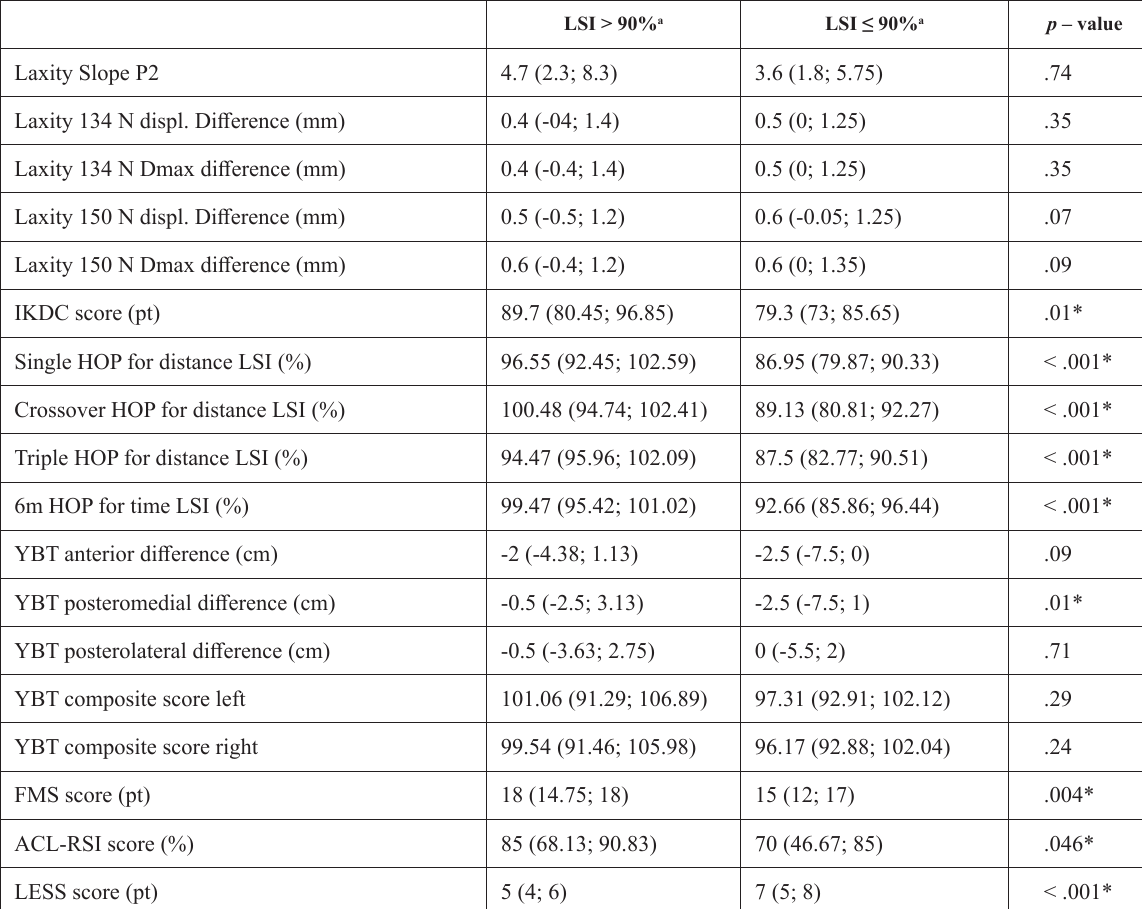
Table 2. Knee function tests and questionnaire scores for each